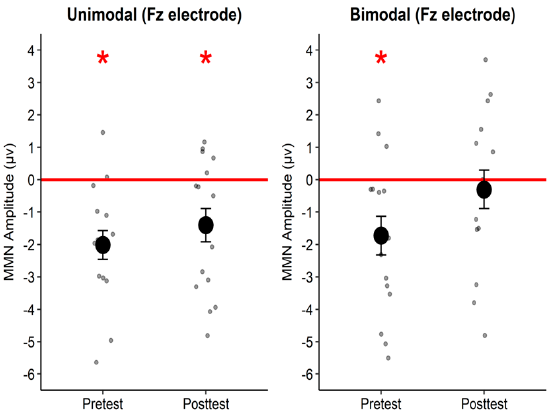
Figure 6. Mean MMN amplitude (large dots) for the two conditions at each test phase. Small dots represent individual data. Error bars represent one standard error. Asterisks represent significant MMN amplitude.